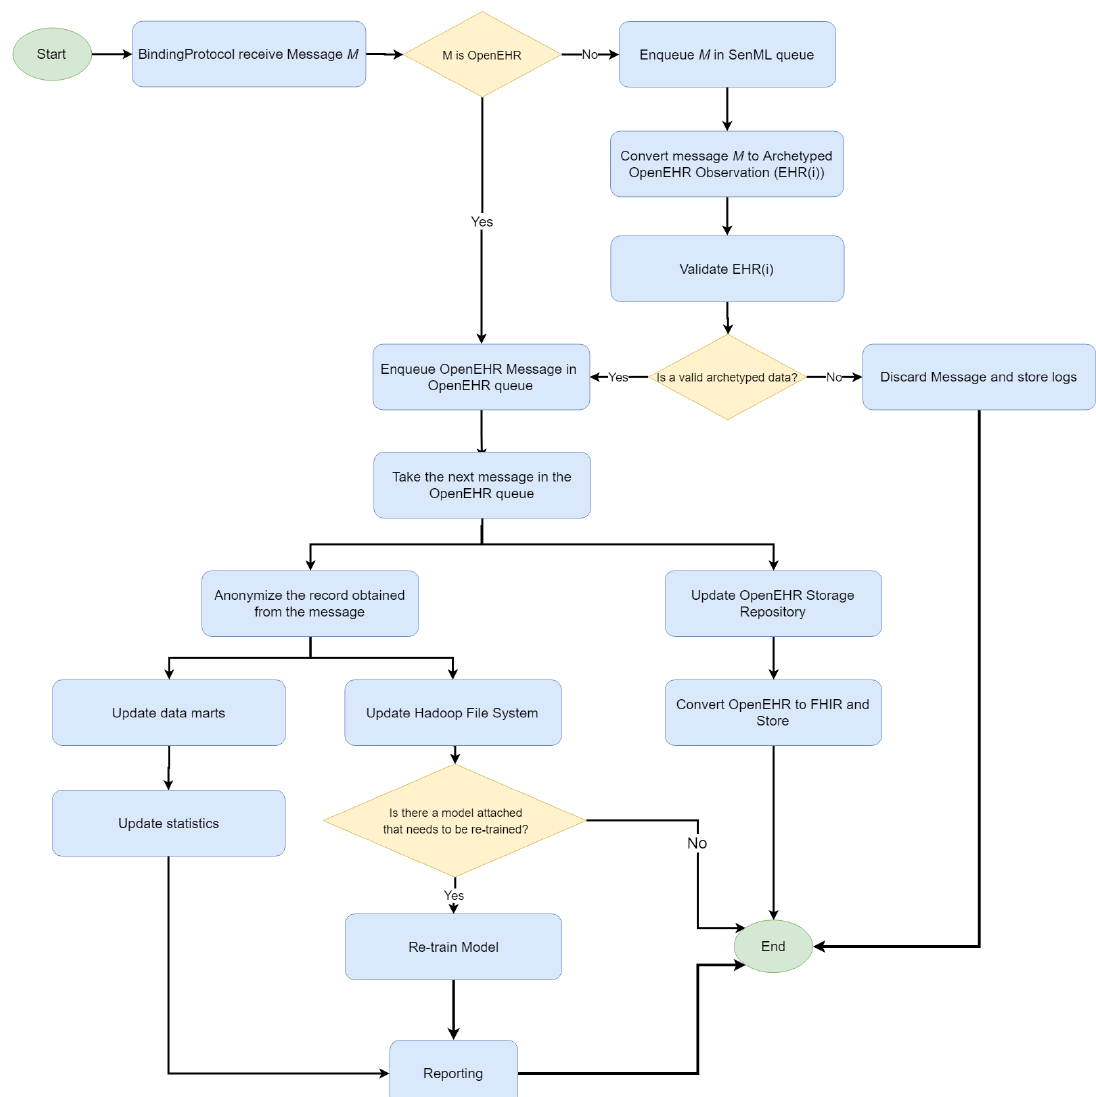
Figure 12. Message handling (Cloud